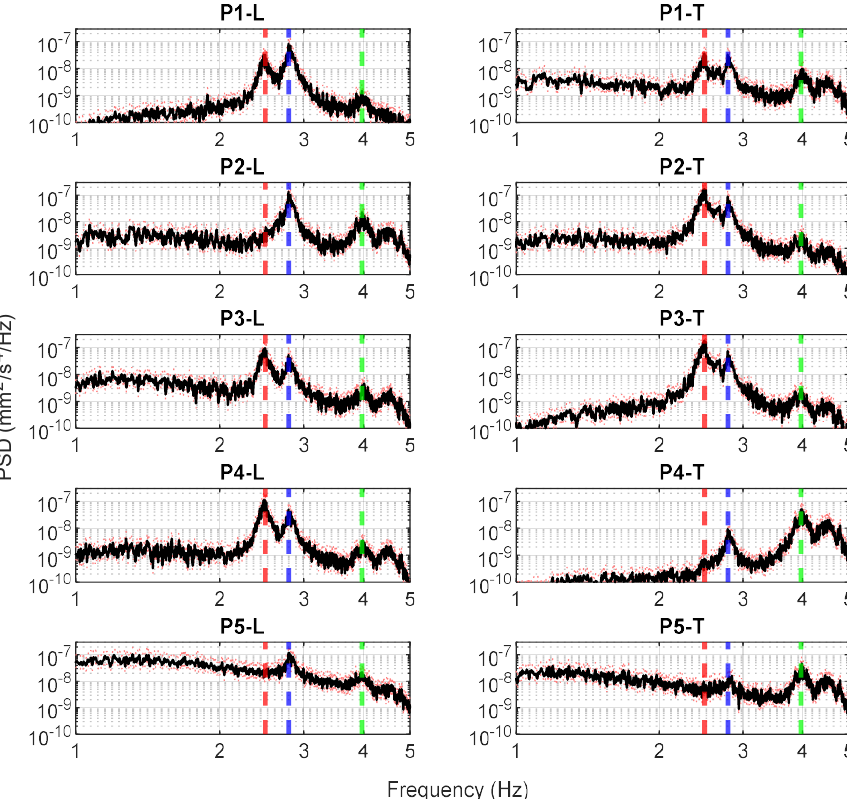
Figure 6. The power spectral density (PSD) for the ten channels acquired through accelerometers. The dashed lines indicate the frequencies 2.49 Hz ( red ), 2.79 Hz ( blue ) and 3.98 ( green ).